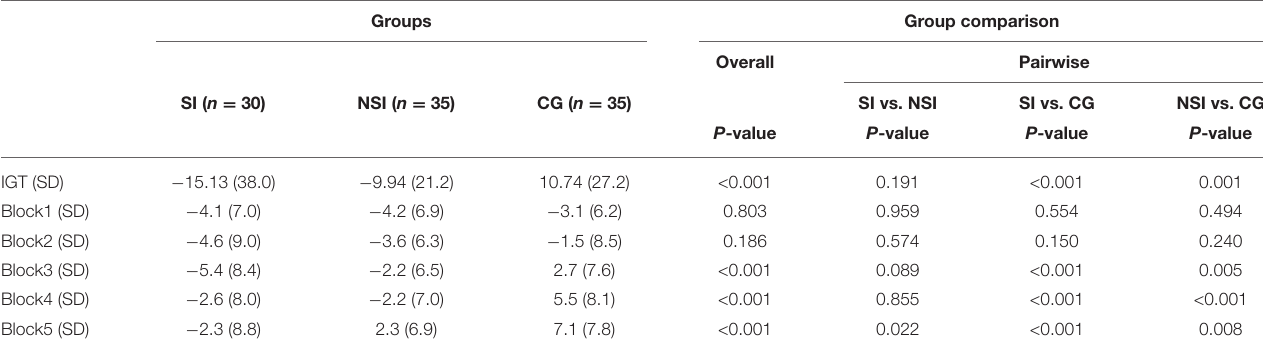
TABLE 3 | Differences in decision-making functions among three groups (SI, NSI, CG). Groups Group comparison